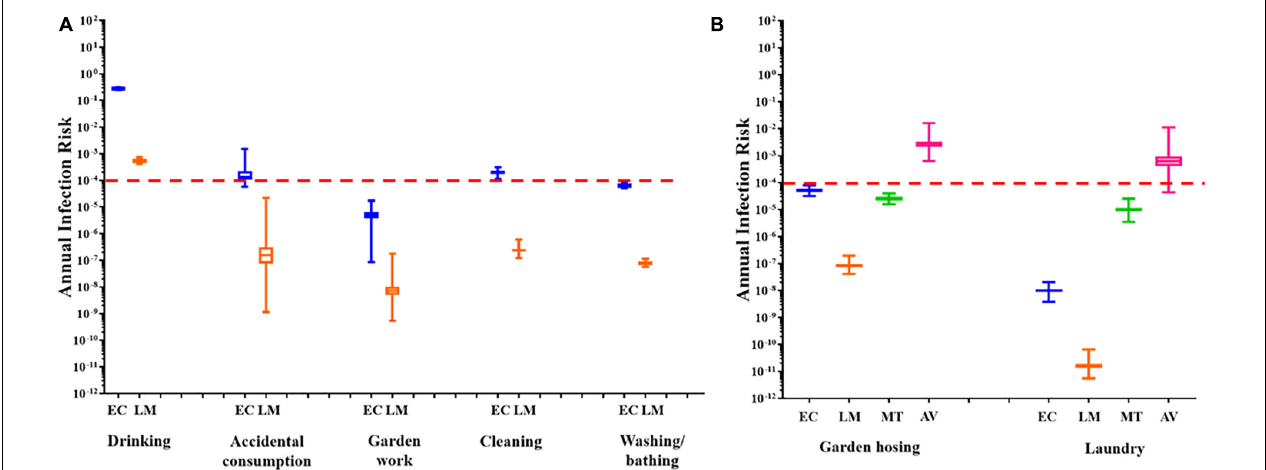
FIGURE 3 | (A) Annual health risk associated with the use of RHRW in the community for ingestion scenarios based on the presence of E. coli (EC; blue ) and L. monocytogenes (LM; orange ). (B) Annual health risk associated with the use of RHRW in the community for inhalation scenarios based on the presence of E. coli (EC; blue ), L. monocytogenes (LM; orange ), M. tuberculosis (MT; green ) and adenovirus (AV; pink ). The whiskers illustrate the minimum and maximum, the outer box illustrates the 1st and 3rd quartiles, and the inner line illustrates the median. The benchmark limit (1 × 10 - 4 ) is indicated by the dashed red